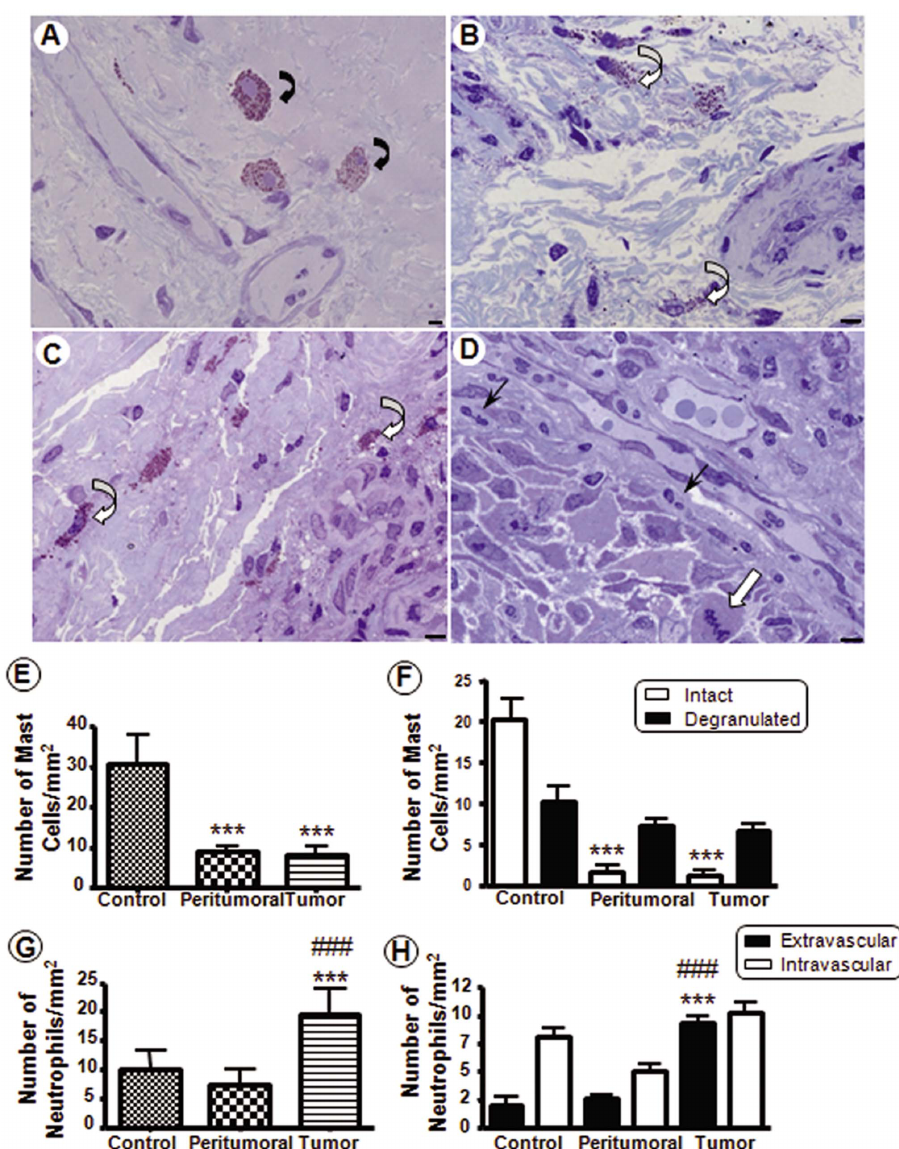
Fig. 1. Influx of inflammatory cells in tumor samples from human laryngeal. ( A–D ) Representative images (original magnification, 6 63) of Toluidine Blue-stained tissue sections from laryngeal samples. ( A ) Control laryngeal sample showing intact mast cells (curve arrows) near the blood vessels. Peritumoral ( B ) and tumor ( C ) samples with degranulated mast cells (open curve arrows). ( D ) Tumor cells with mitotic activity (open arrow) and inflammatory cells, as extravascular neutrophils (arrows). ( E ) Total number of mast cells. ( F ) Intact and degranulated mast cells. ( G ) Total number of neutrophils. ( H ) Extra and intravascular neutrophils. Data are expressed as the mean ¡ SEM of the cell number per mm 2 (n 5 20 patients per group). One-way ANOVA followed by Bonferroni’s test revealed a significant difference among the groups. *** P , 0.001 vs. control, ### P , 0.001 vs. peritumoral. Scale bars: 5 m m.